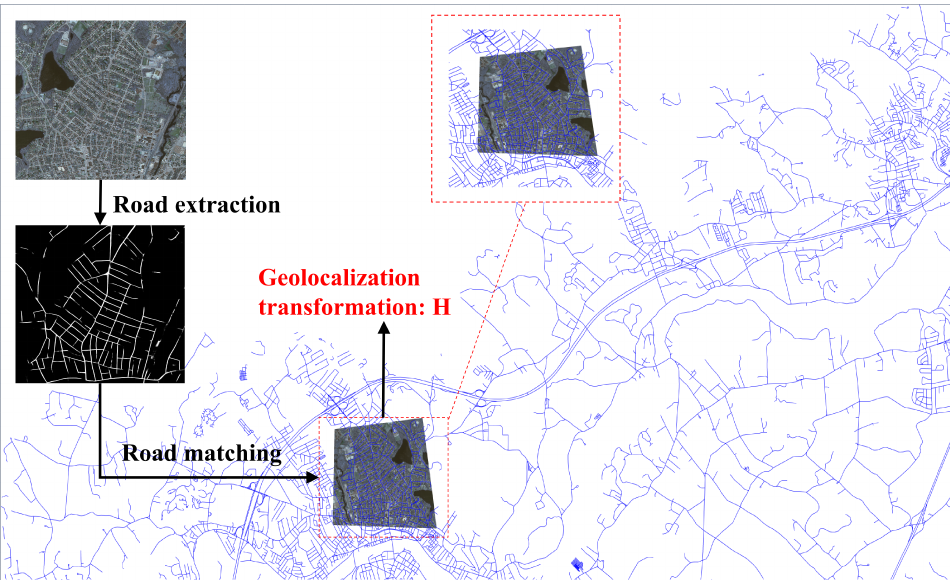
Figure 1. The motivation of this study: performing efficient geolocalization directly on query aerial images by matching the roads in the aerial images with those in the reference road map (in blue) over an area as large as a whole city. Geolocalization is the task of estimating a transformation that aligns the aerial image to a certain Geographical Coordinate System (GCS). To make it clearly seen, only parts of the reference road map are shown